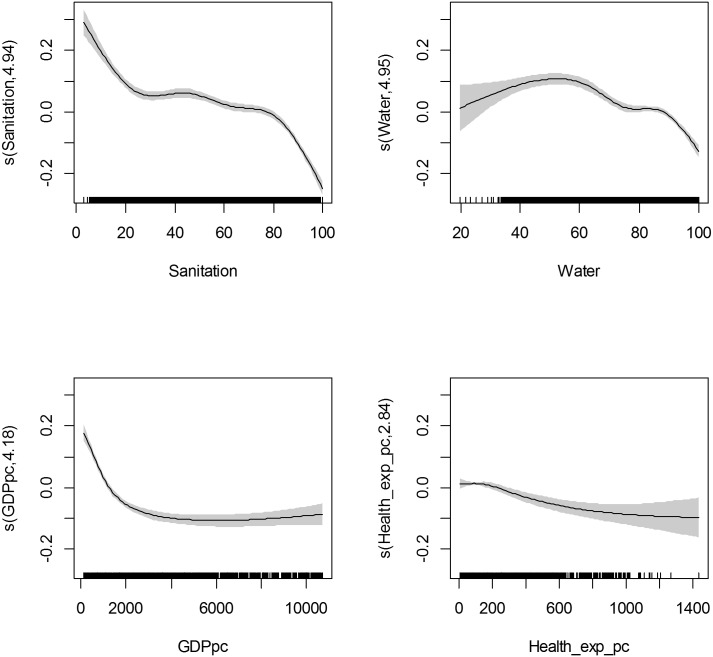
Partial residual plots showing impact on water and sanitation coverage at national level on log10 neonatal mortality per 1000 live birthsa.aEach y axis shows the partial residual plot of the predictor with the relevant estimated degrees of freedom, with the partial residuals having a mean of zero. A decline of 1.0 along the y axis would equate to one log reduction in the outcome variable with the relevant change in the appropriate predictor assuming the other predictors remained constant. The grey shaded area represents the 95% confidence intervals. The small lines on the x axis represent the data points.